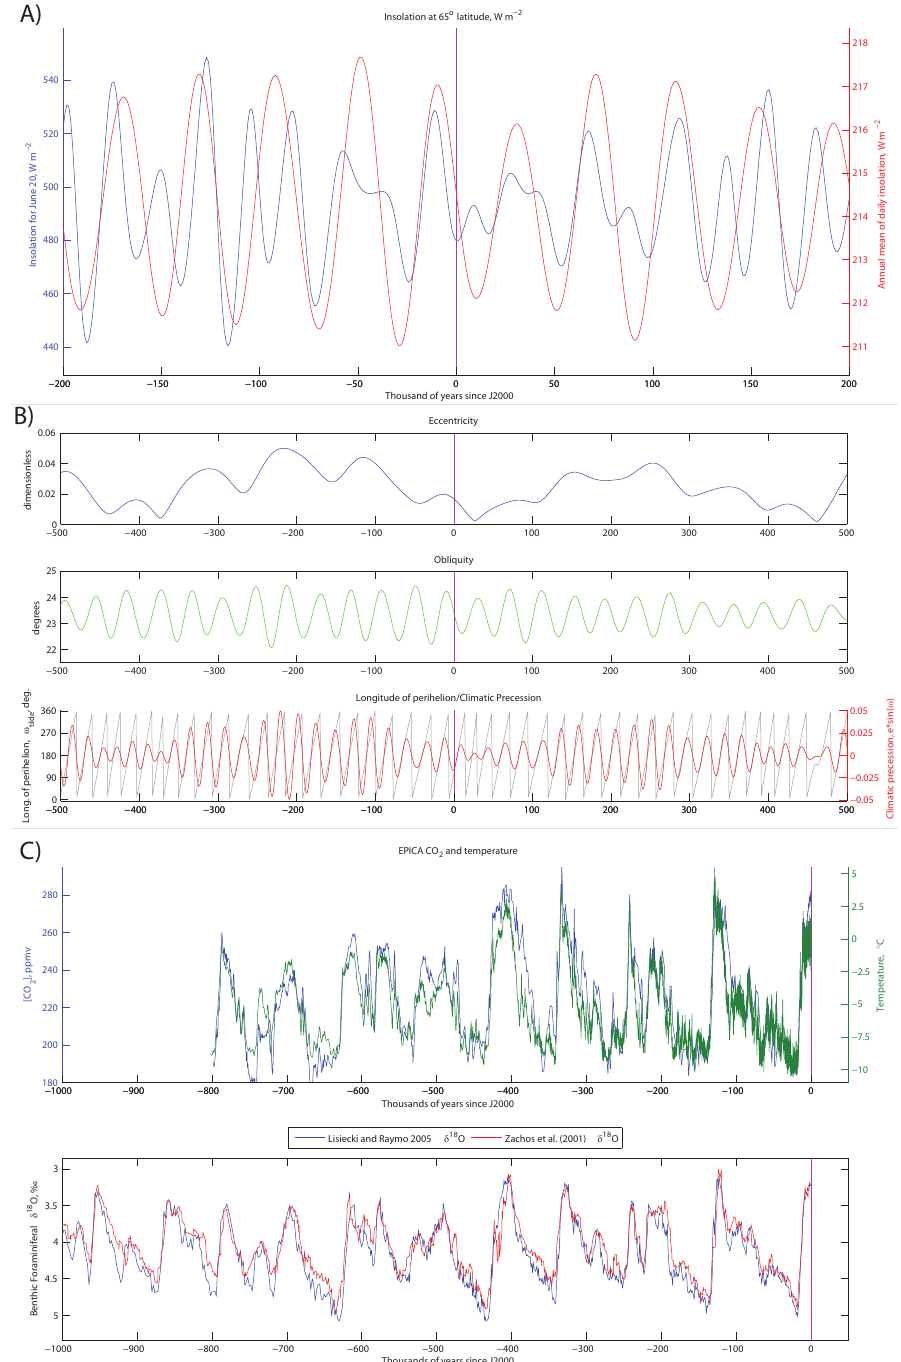
Figure 4. (A) Insolation time-series plot spanning 200kyr before and after present (J2000) at 65 ◦ N on 20 June (blue) and annual average (red); (B) time-series plots of Milankovitch orbital parameters spanning 500kyr before and after present. Panels from top to bottom display eccentricity, obliquity, and longitude of perihelion and climatic precession; both (A) and (B) use the La2004 solution. (C) Time-series plots of paleoclimatic data spanning one million years before present: EPICA ice core CO 2 (blue) and deuterium temperature (green) (upper panel) and the Lisiecki and Raymo (2005) (blue) and Zachos et al. (2001) (red) compilations of benthic oxygen isotope ( δ 18 O) data (lower panel). Note the y axis of the δ 18 O plot is inverted. Negative years for all Fig. 4 panels are in the